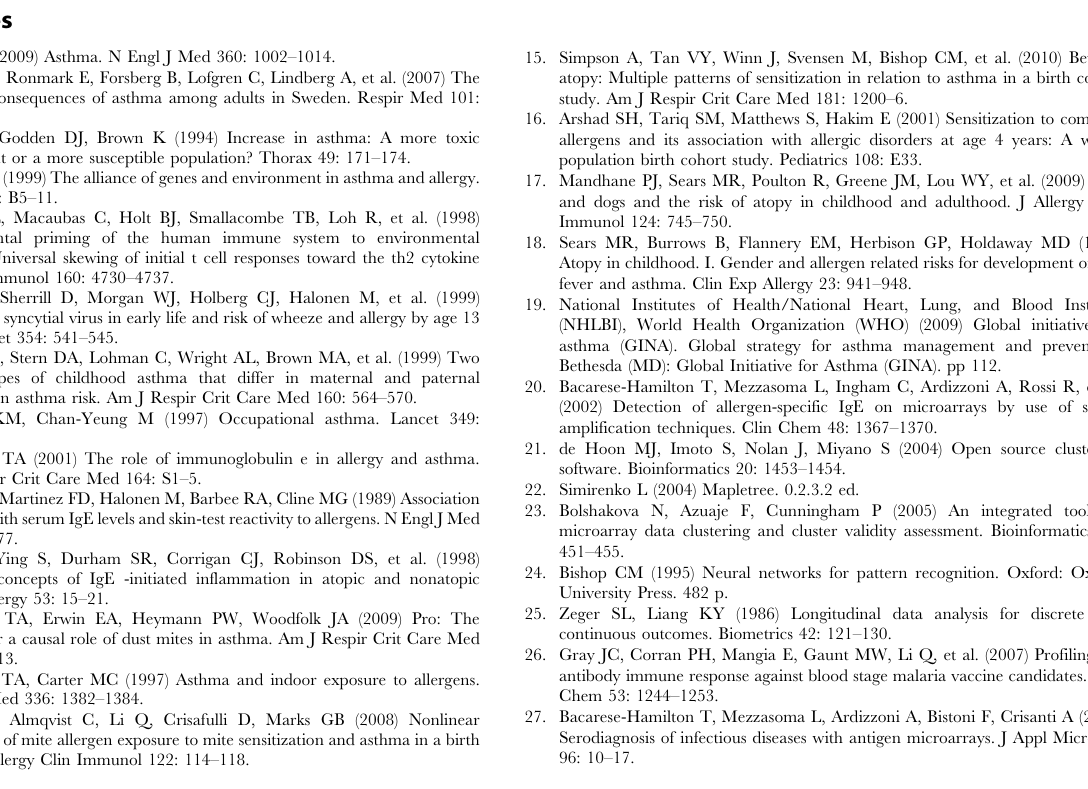
Table S7 Distribution of atopic traits amongst the filtered reactivity profiles. (DOC) Table S8 Segregation of family nuclei in the filtered clusters. Table S9 Univariate GEE analysis results between asthma and specific IgE against all tested allergens. Table S10 Distribution of atopic traits amongst the reactivity profiles. Table S11 Segregation of family members in the clusters 6–8. Figure S1 Visual representation of the reactivity pat- terns of cluster 3, 4 and 5. The numbers on the x axis correspond to the asthma relevant allergens (list on Table S6), the y axis shows the corresponding class score serum reactivity (0–5) in term of mean value red circles), the interquartile range (IQR- blue vertical lines) and the medians (horizontal lines of the